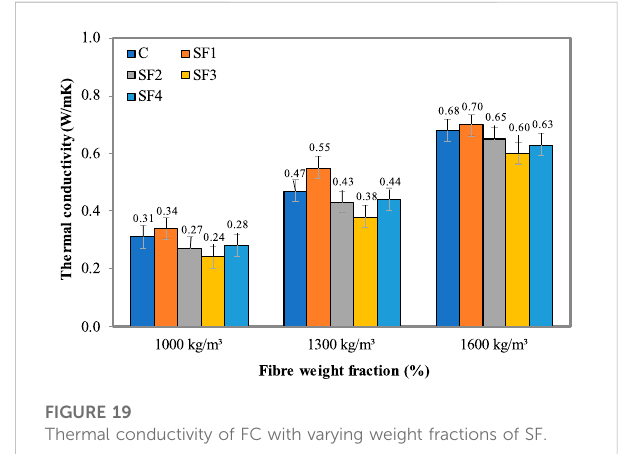
FIGURE 19 Thermal conductivity of FC with varying weight fractions of SF.